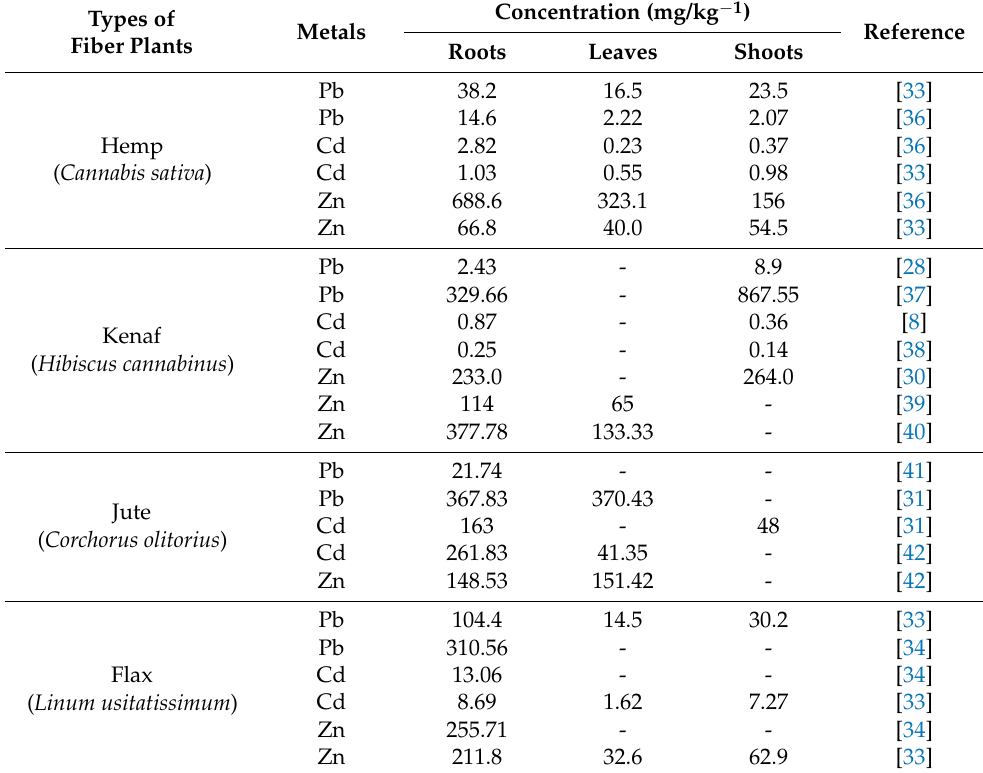
Table 3. Heavy metal concentration in Bast Fiber Plants. Listed tissues represent those with the highest concentration of metals in the roots, leaves and